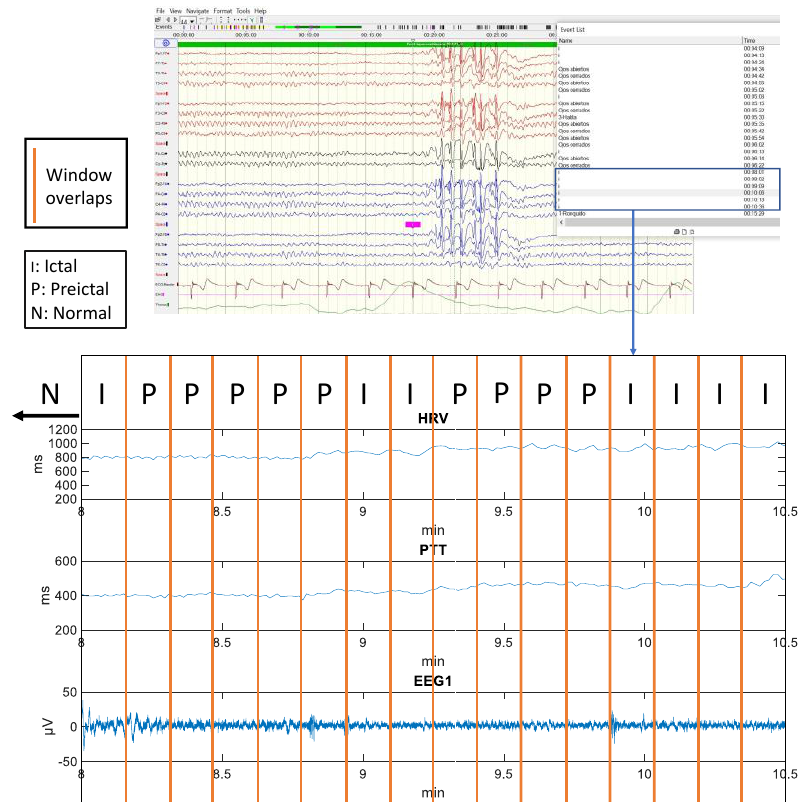
Figure 5. Example of classification of status epilepticus based on the information provided by the medical